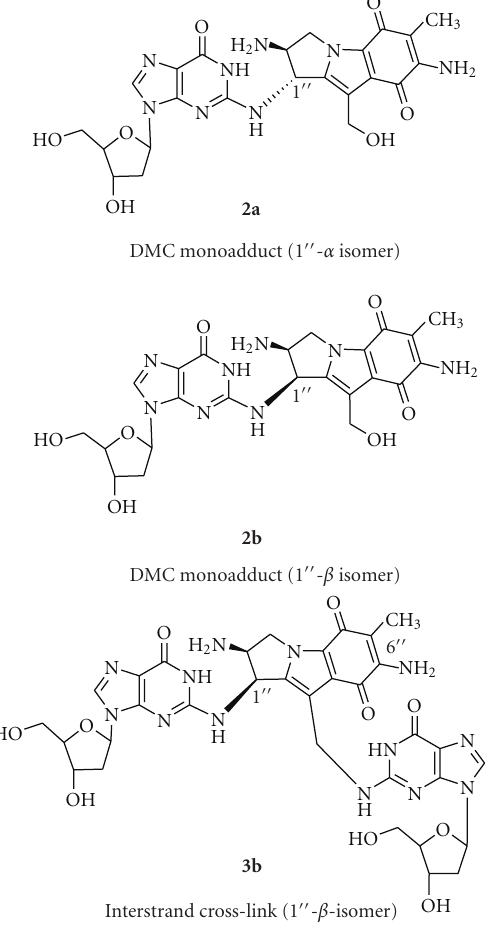
Figure 3: Chemical structures of major adducts of DMC. (Repro- duced with permission from the reference in Figure 1.